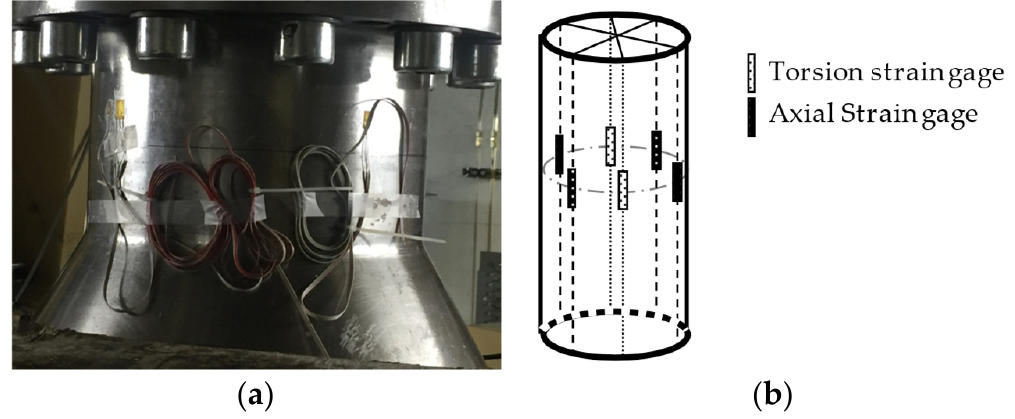
Figure 2. ( a ) Installed strain gages on the turbine shaft, ( b ) arrangement of the strain gages on the turbine shaft [18].